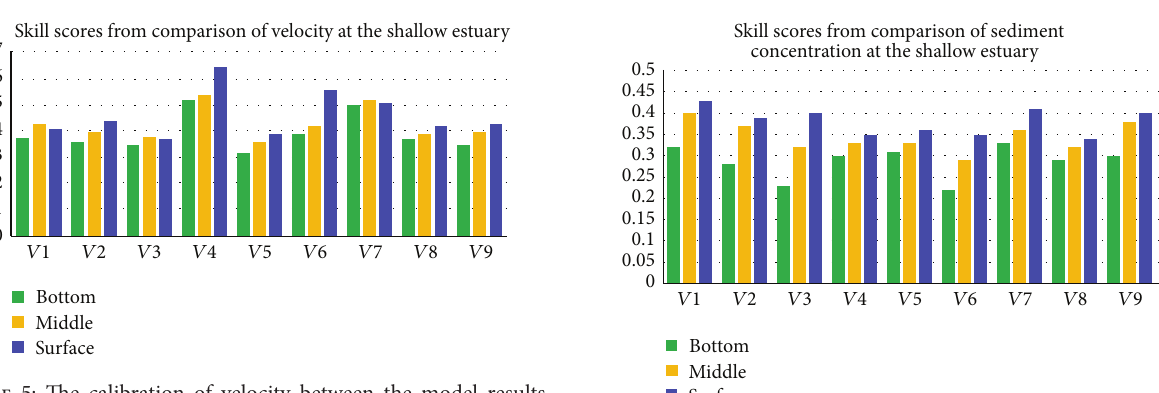
Figure 5: The calibration of velocity between the model results and observations at 9 stations in the Pearl River Estuary is shown. The calibration of the velocity at the surface (blue), the middle (yellow), and the bottom (green) is deployed. The result shows a good performance with the skill scores of the velocity ranging from 0.4 to 0.6.